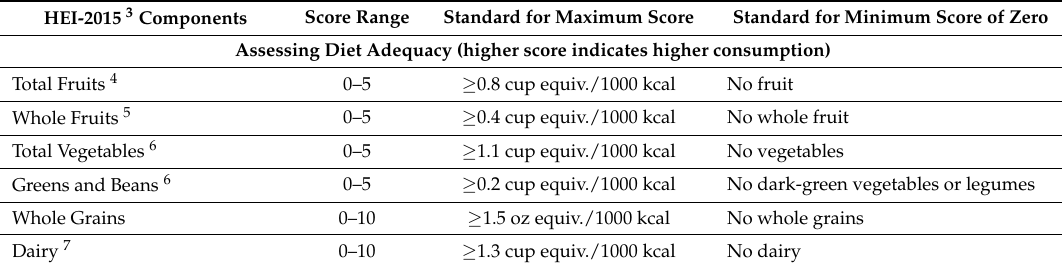
Table 1. HEI-2015 and HES-5 components and scoring rubric 1,2